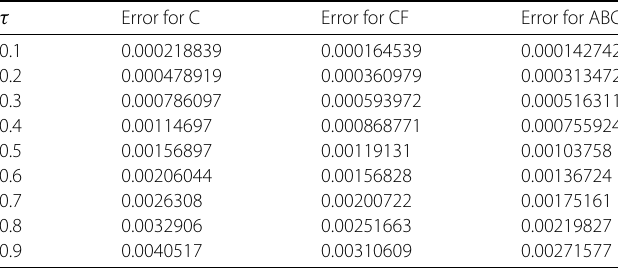
Table 1 AREs of x ( τ ) obtained by fourth-order OPIA solutions using different fractional operators at β =